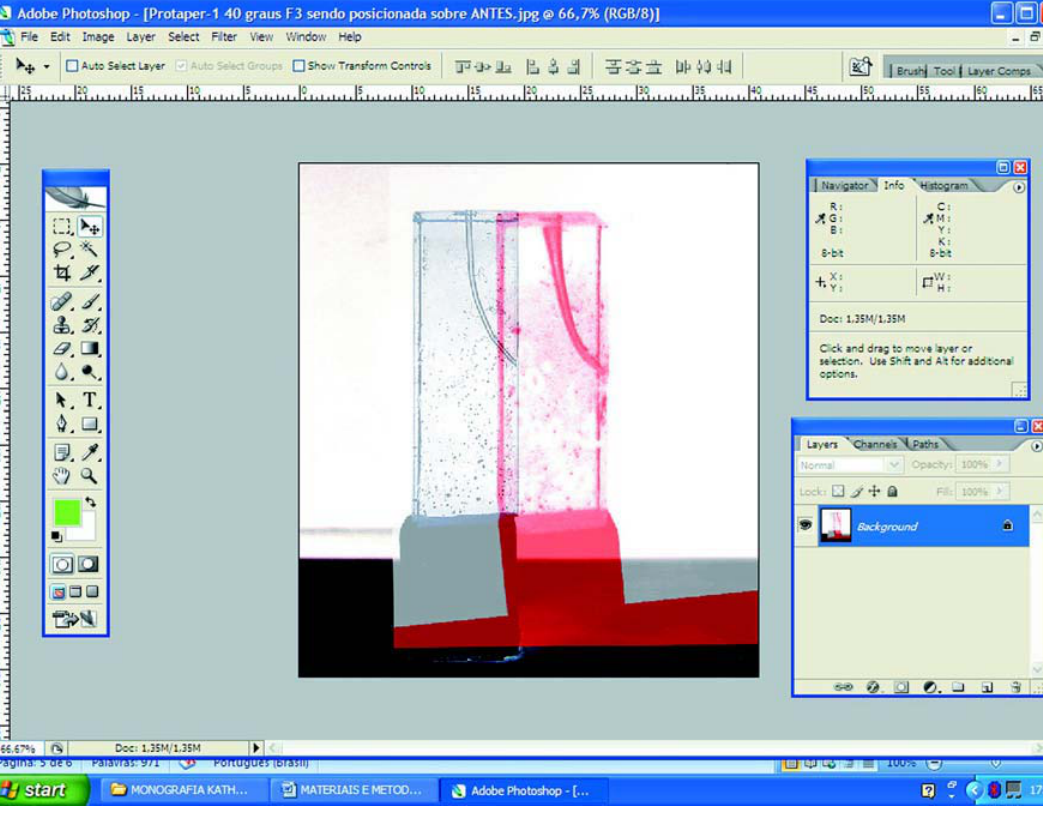
FIGURE 2- Image of an instrumented canal superimposed onto the image of a non-instrumented